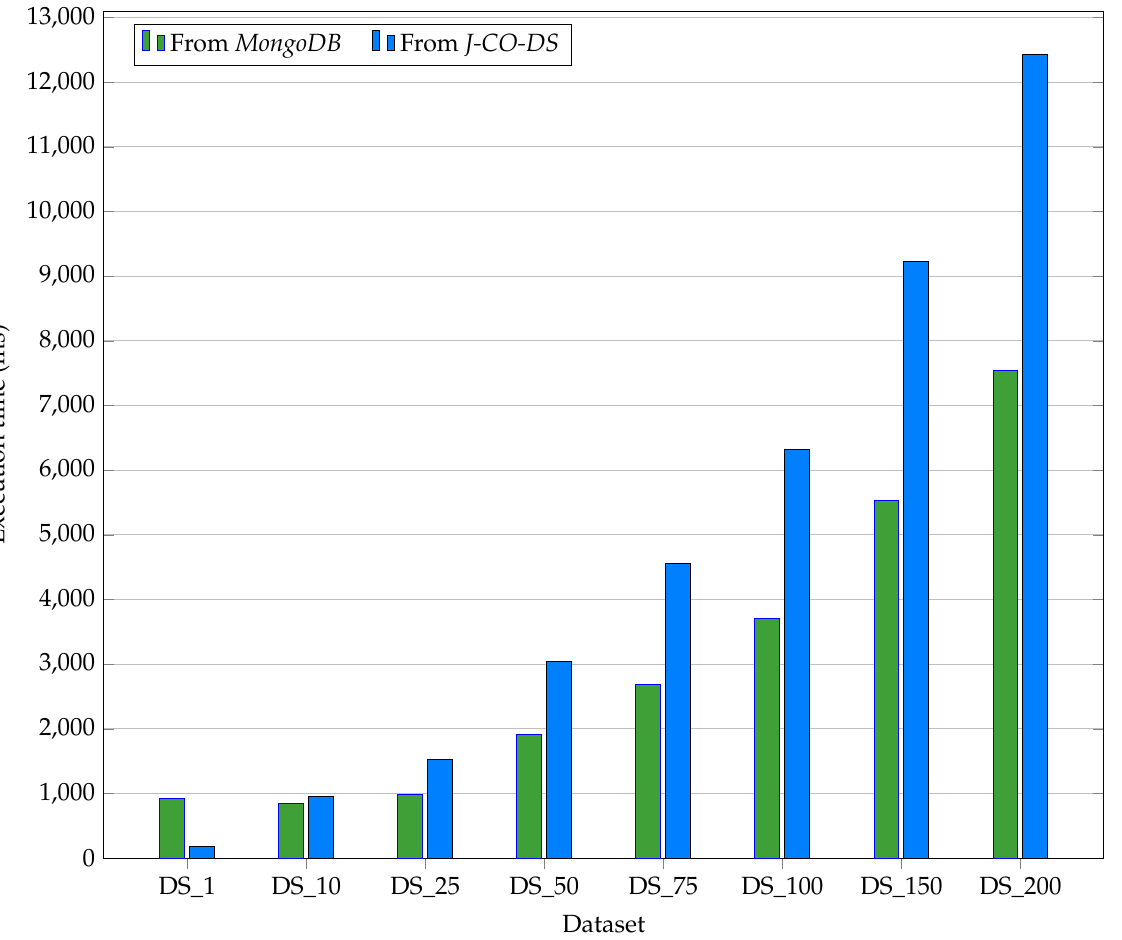
Figure 9. Performance comparison between MongoDB and J-CO-DS (for getting